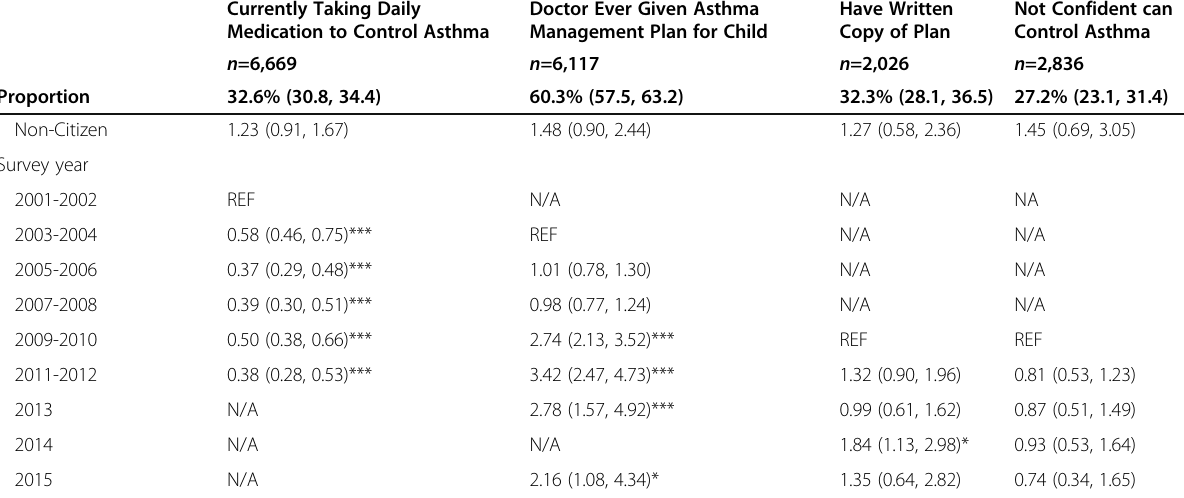
Table 3 Logistic Regression for Asthma Management (Continued) Currently Taking Daily Medication to Control Asthma